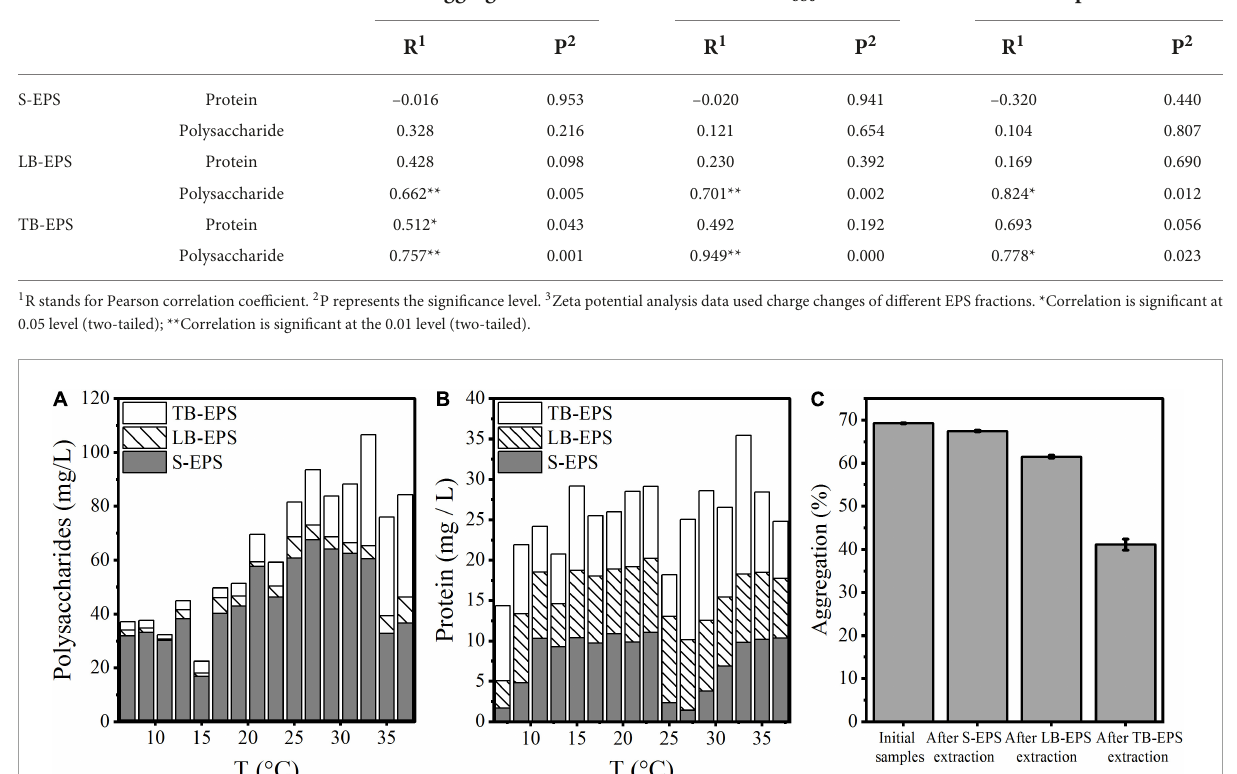
TABLE 1 Pearson correlation analysis of the aggregation, algal density, zeta potential, and protein and polysaccharide in EPS components. Aggregation